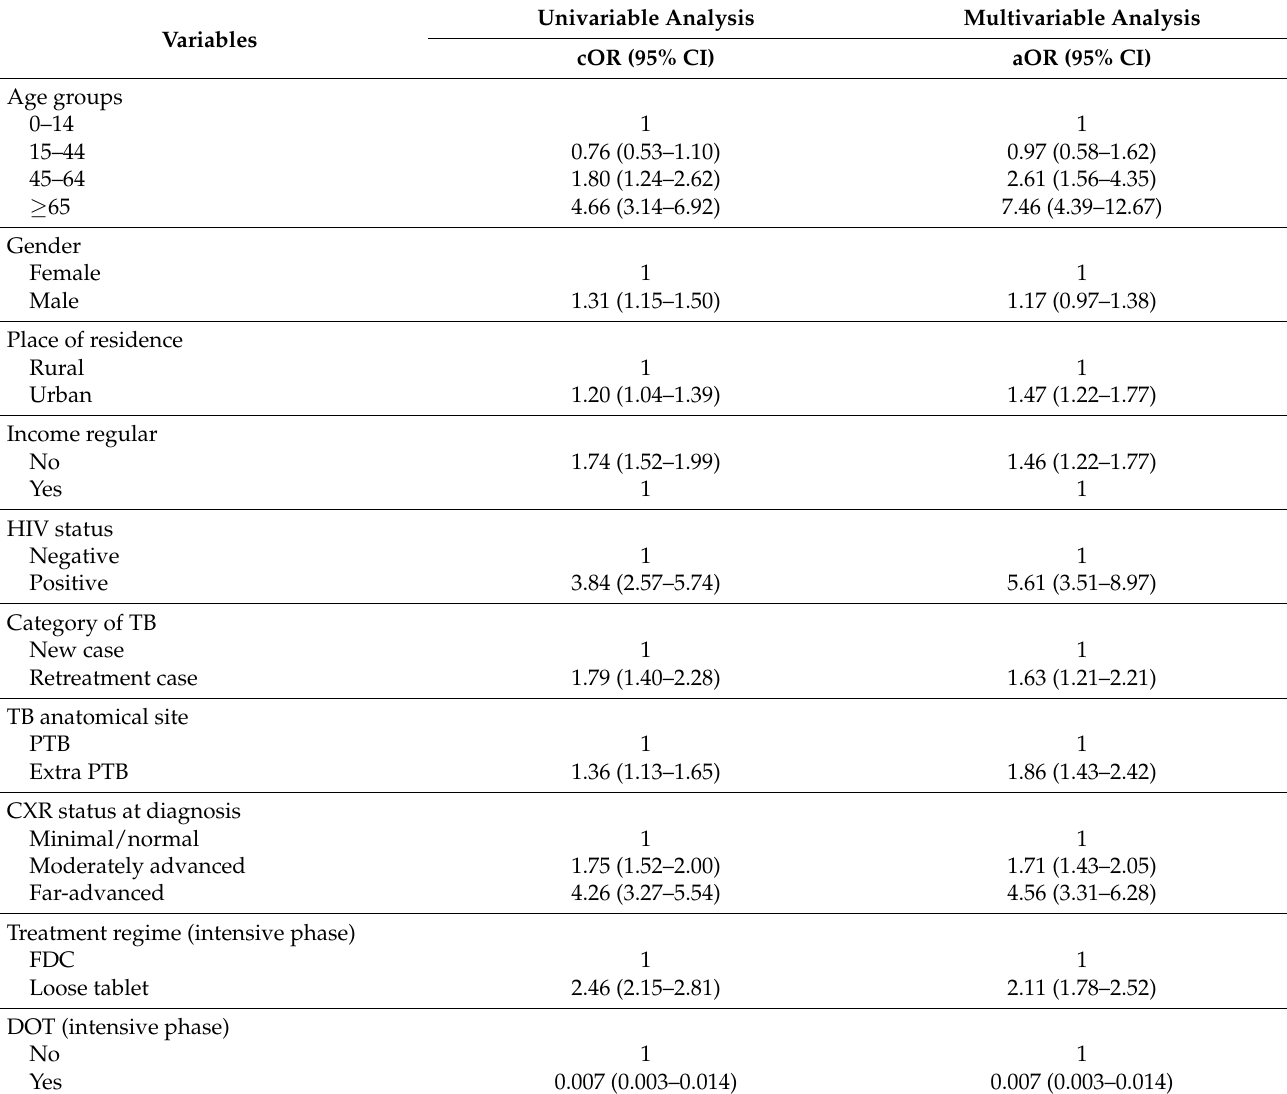
Table 5. Binary logistic regression analysis of risk factors for all-cause TB